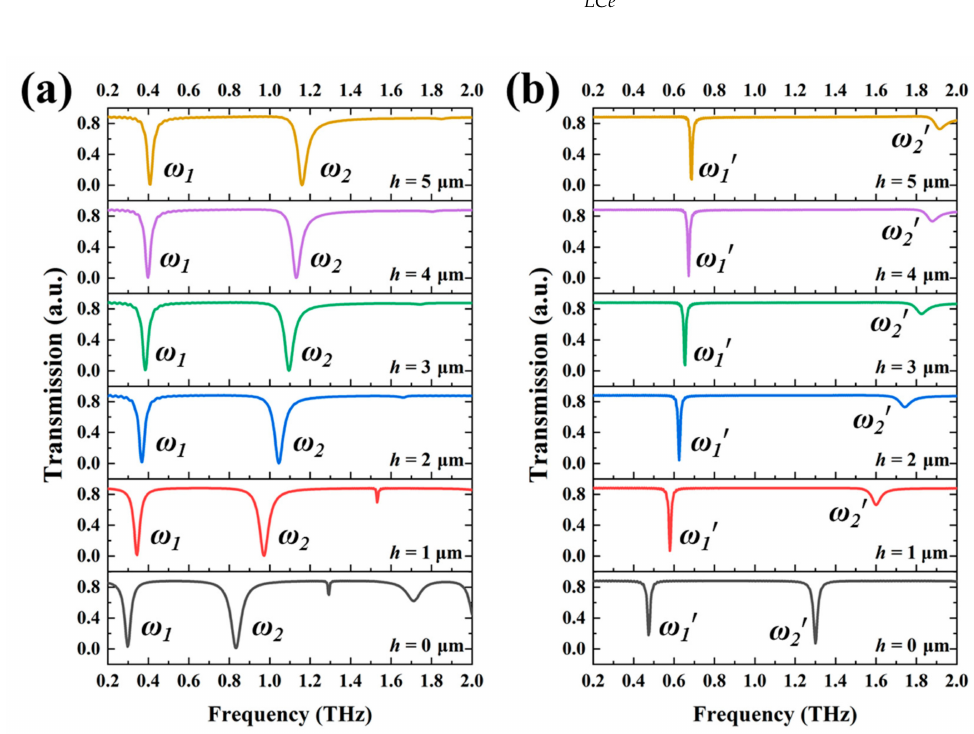
Figure 2. Transmission spectra of ( a ) SRR-1 and ( b ) SRR-2 by changing h parameter from 0 µ m to 5 µ